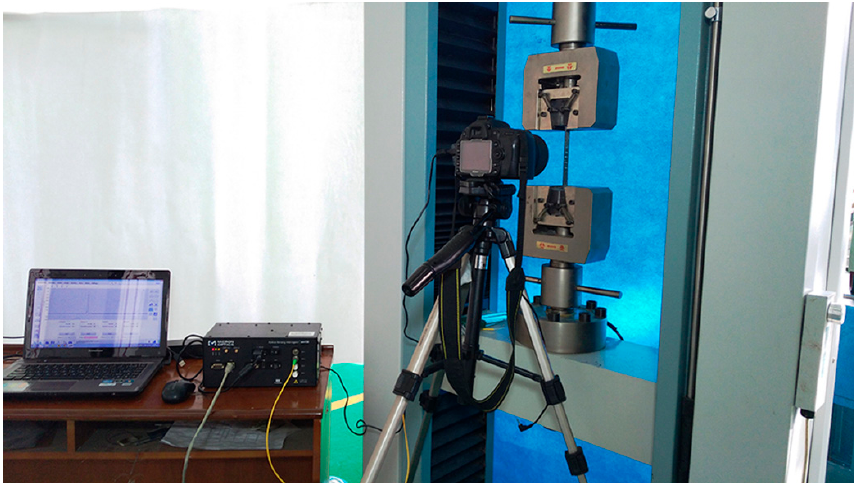
Figure 1. The configuration and the dimension of the specimens for the uniaxial tensile test.